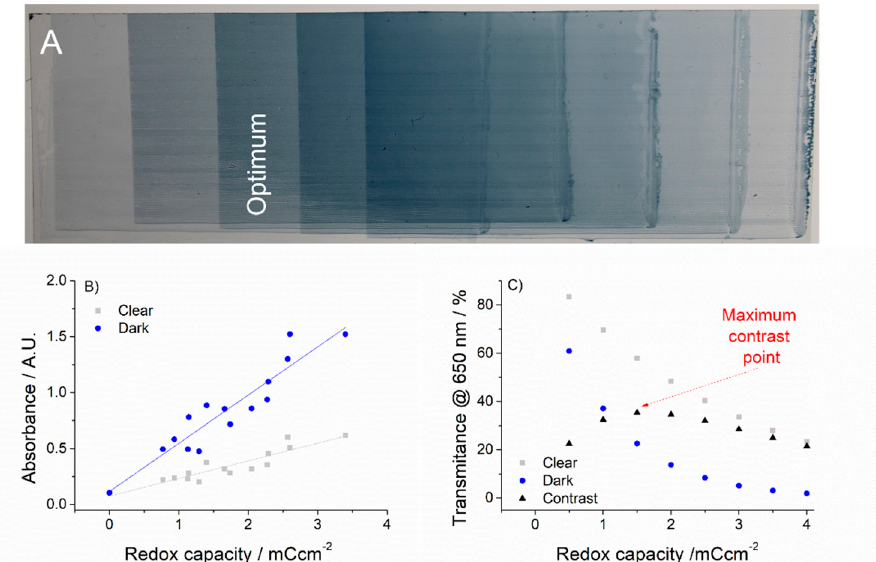
Figure 2. ( A ) Variable thickness PEDOT-PSS films deposited over the PET substrate where the op- timum film is highlighted. ( B ) Absorbance vs. redox capacity of the films in their oxidized (clear) and neutral (dark) states. ( C ) Transmittance vs. redox capacity in their oxidized (clear) and neutral (dark) states, together with the corresponding contrast, where the maximum contrast value is iden- tified (red arrow).